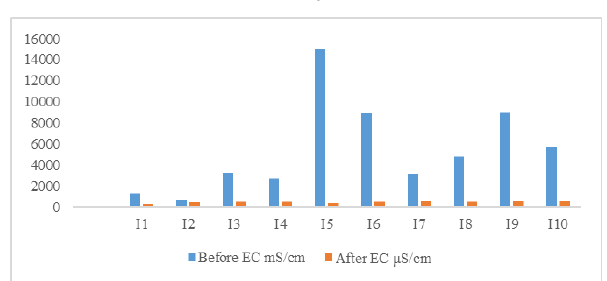
Fig. 5. TDS of Samples before and after Treatment, Islamkot City